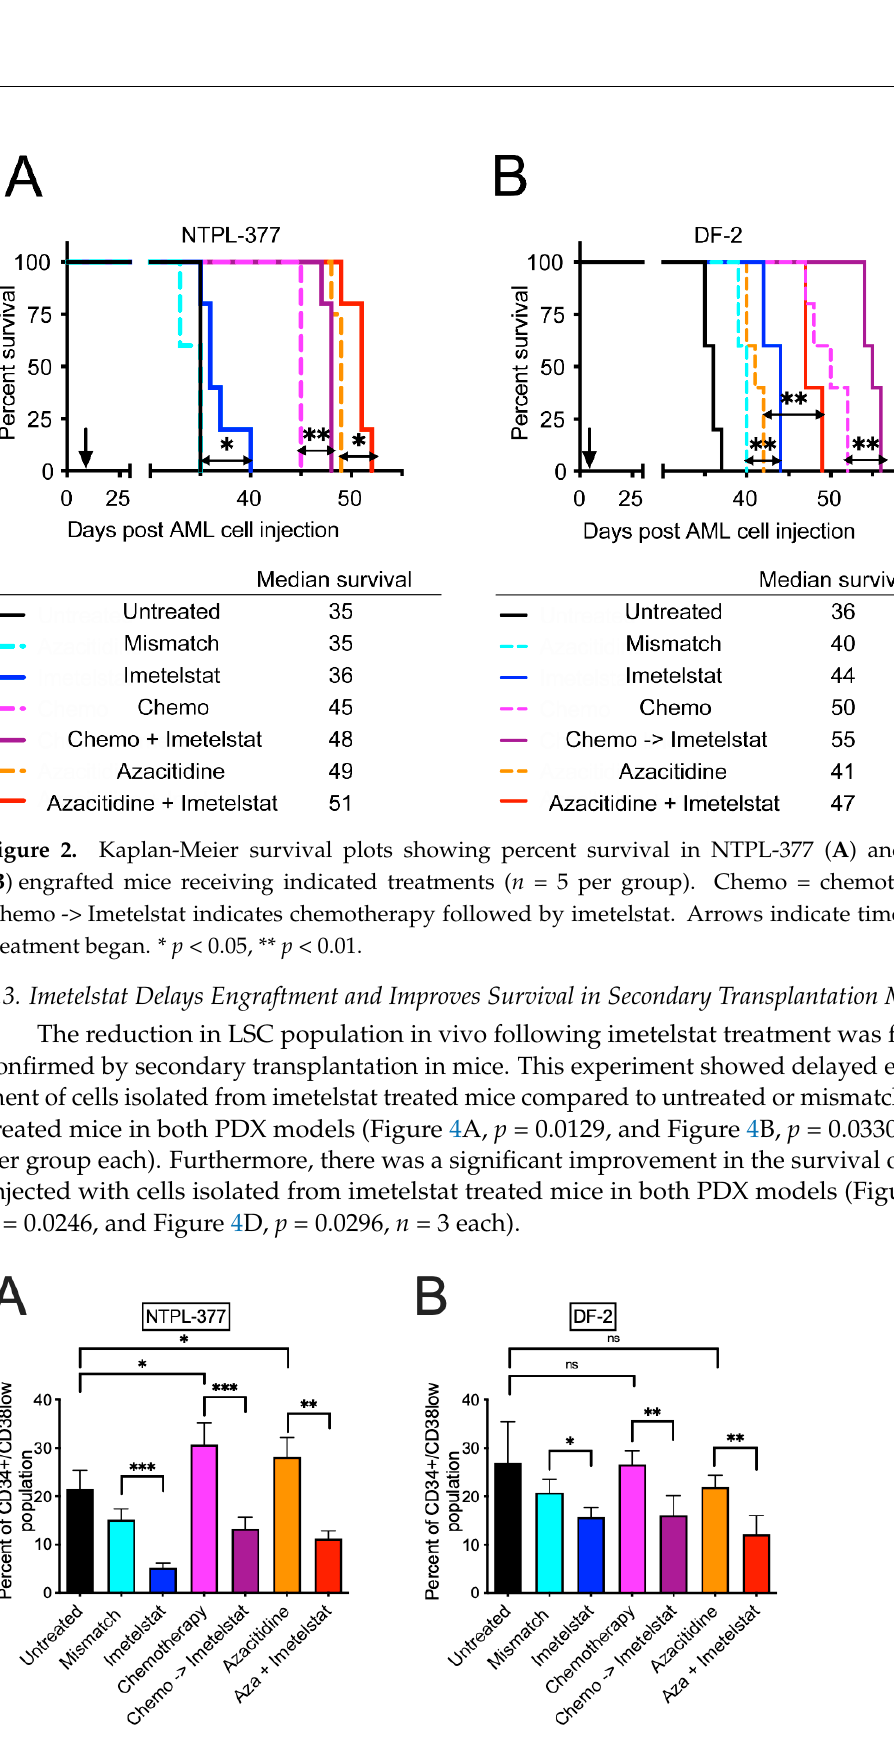
Figure 3. Percentage of LSC population in terminal bone marrow samples isolated from mice post euthanasia in NTPL-377 ( A ) and DF-2 ( B ). Chemo = chemotherapy, Chemo -> Imetelstat indicates chemotherapy followed by imetelstat. * p < 0.05, ** p < 0.01, *** p < 0.001, ns = not significant.